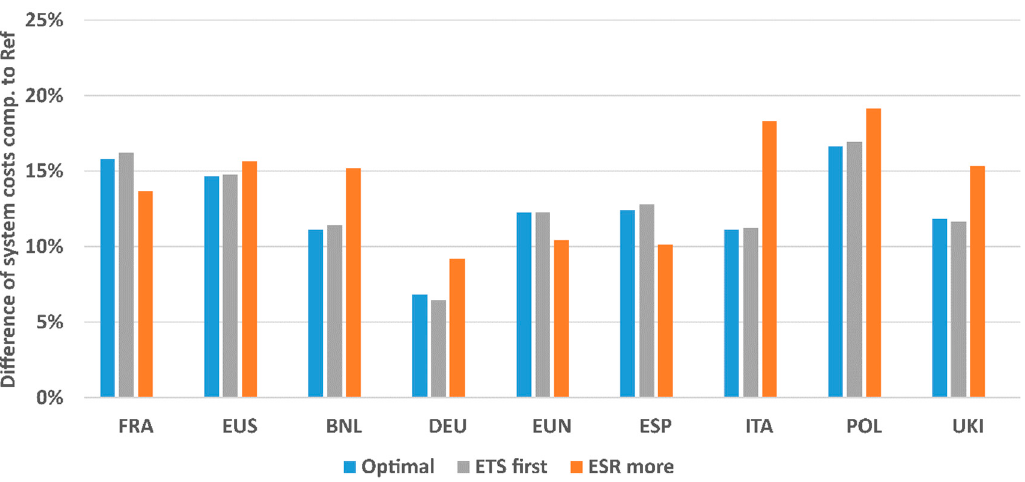
Figure 11. Deviation of the annualised system costs in 2050 compared to the reference scenario.